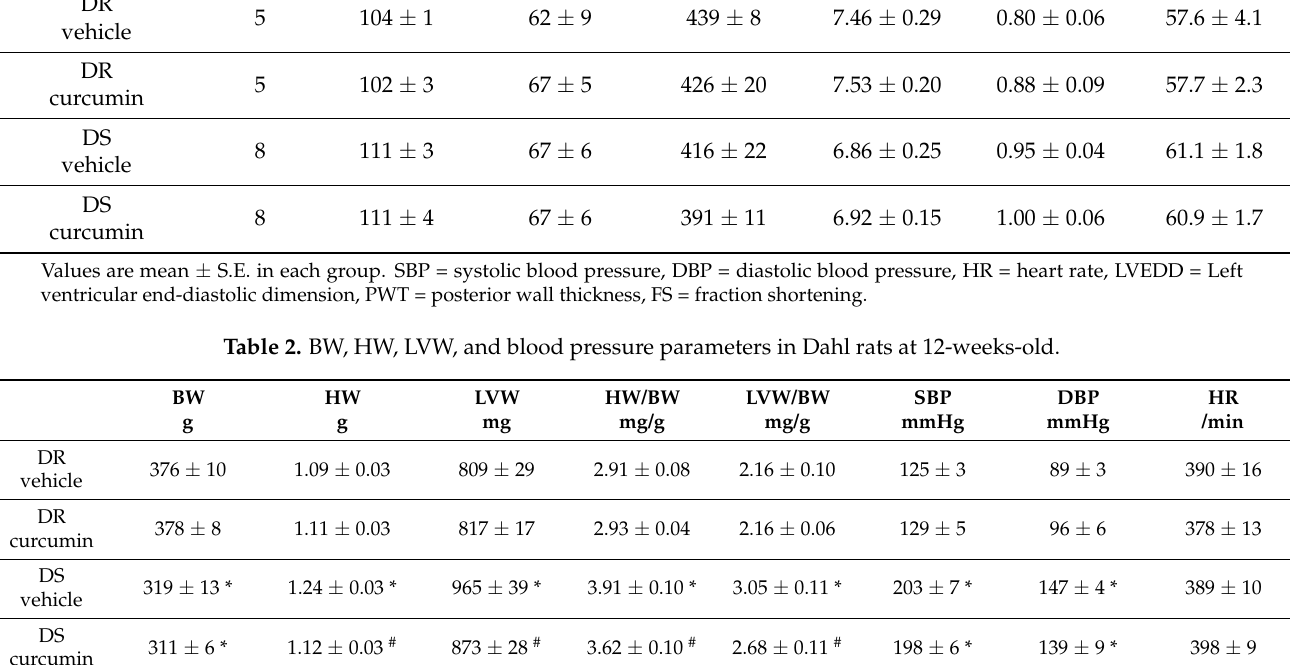
Table 1. Hemodynamic parameters in Dahl rats at 6-week-old.